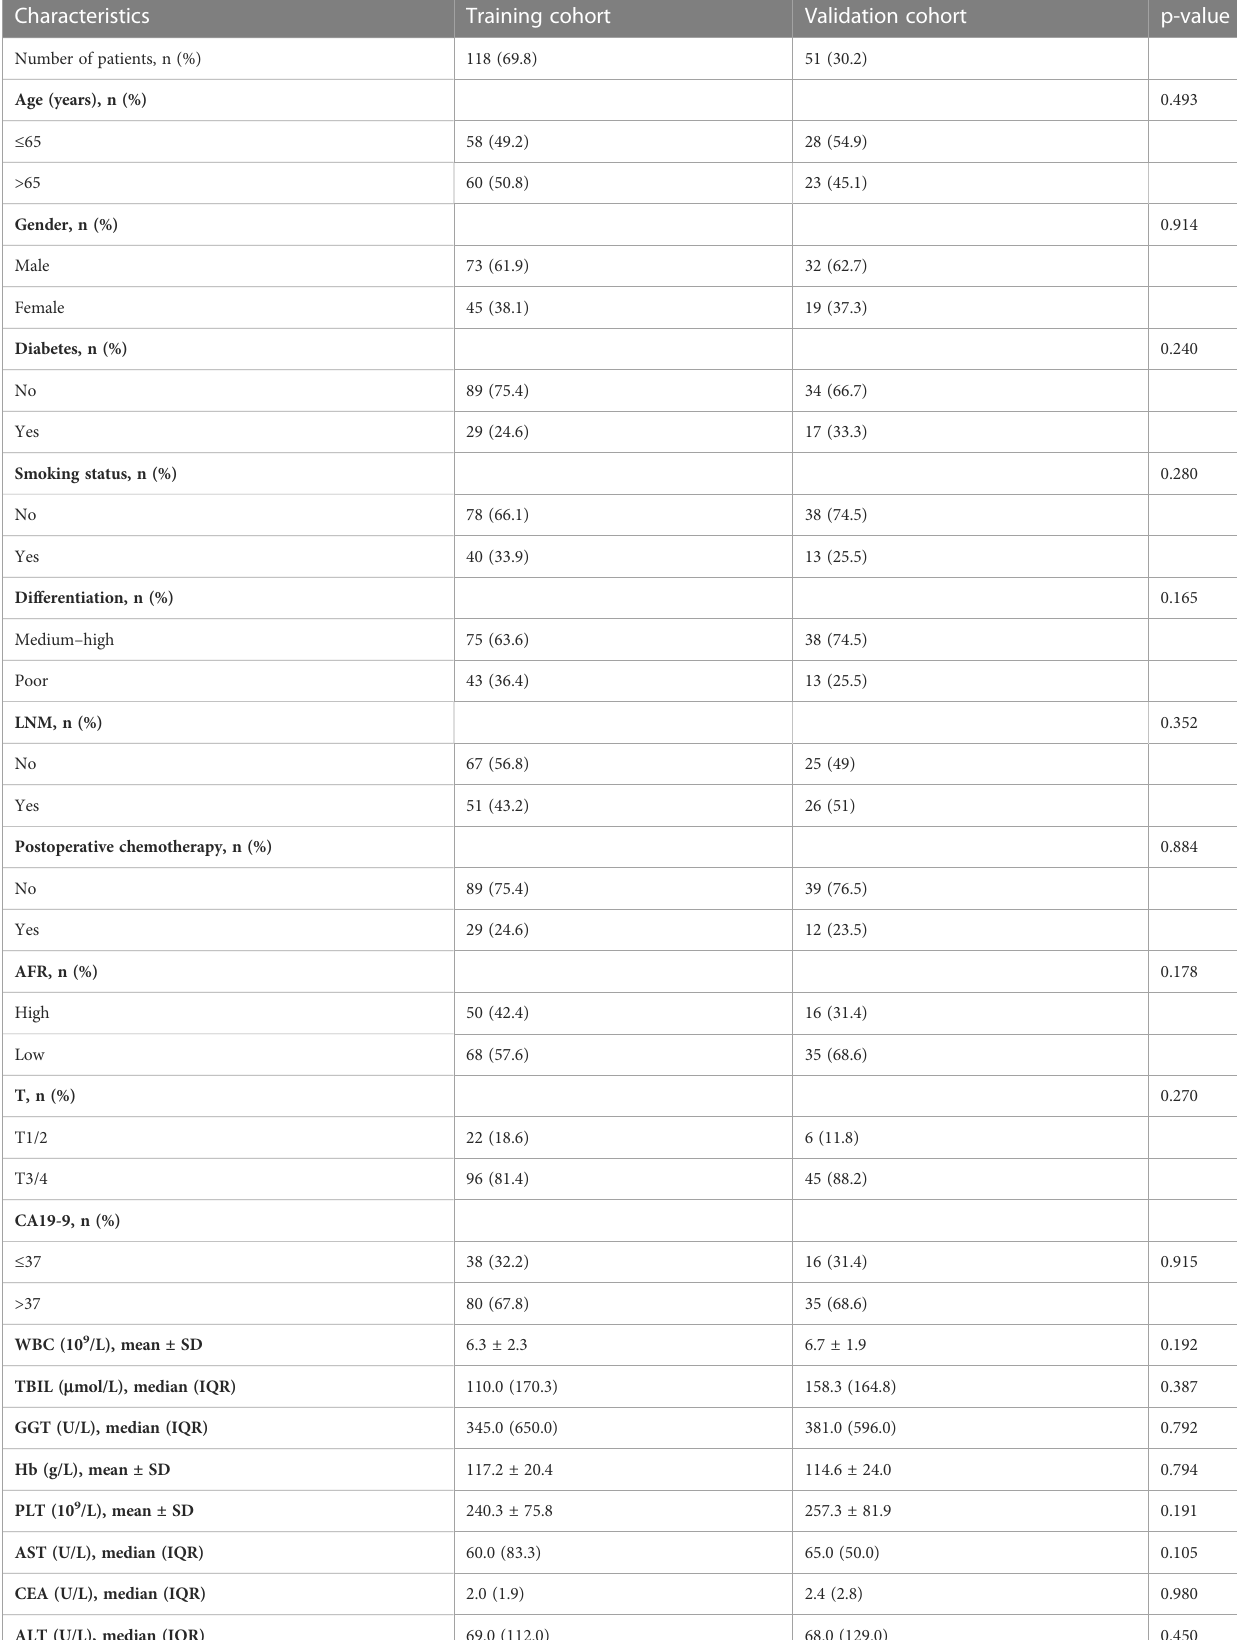
TABLE 1 Clinical and pathologic characteristics of 169 patients with